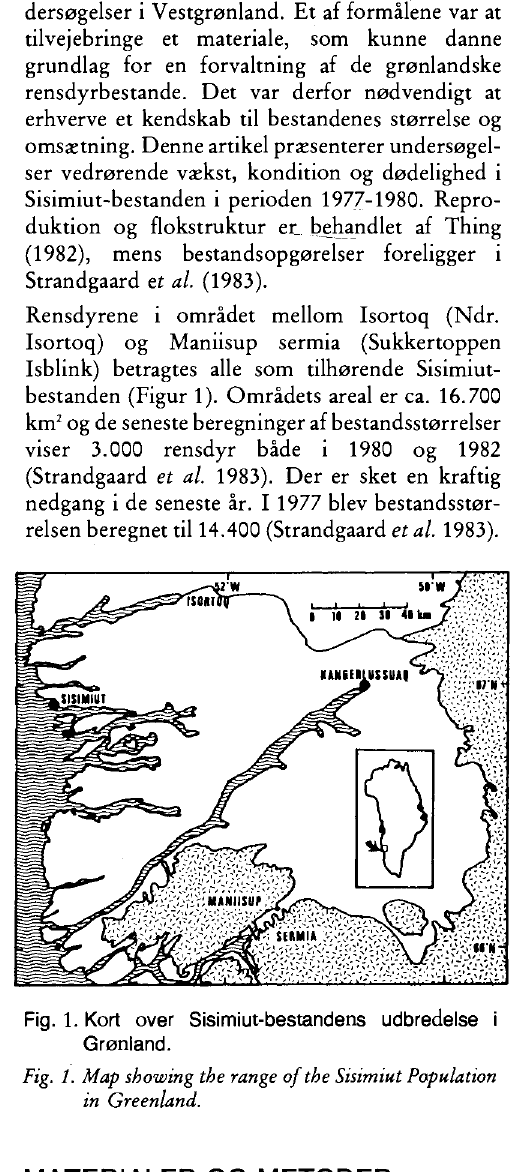
Fig. 1. Kort over Sisimiut-bestandens udbredelse i Grønland. Fig. 1. Map showing the range of the Sisimiut Population in Greenland.